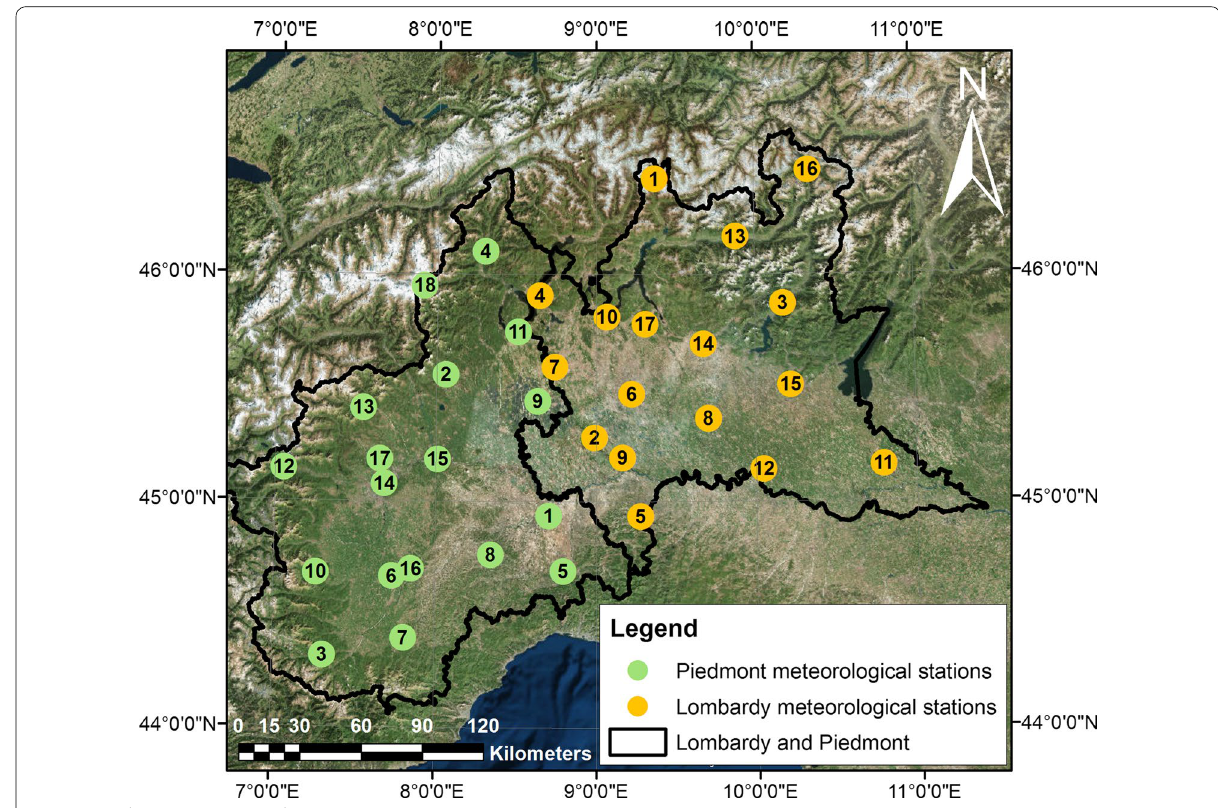
Fig. 2 Weather stations